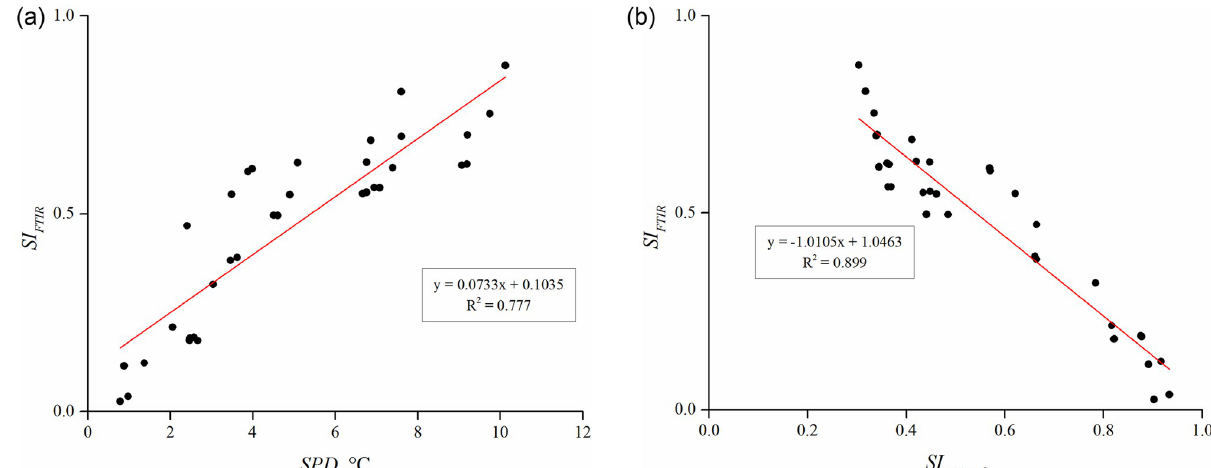
Fig 11. Chemical separation index ( SI